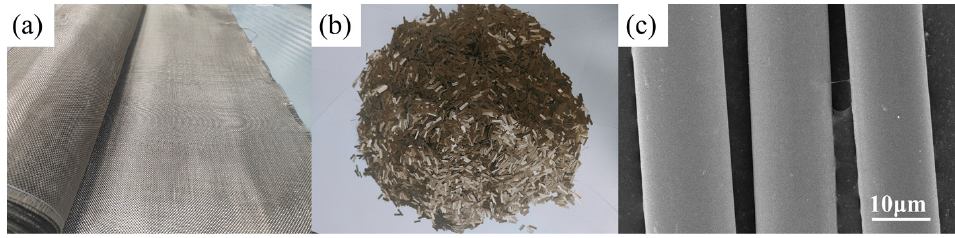
Figure 3. Shape and appearance of BF, ( a ) BF sheet, ( b ) short-cut BF, and ( c ) scanning electron microscopy image of BF.